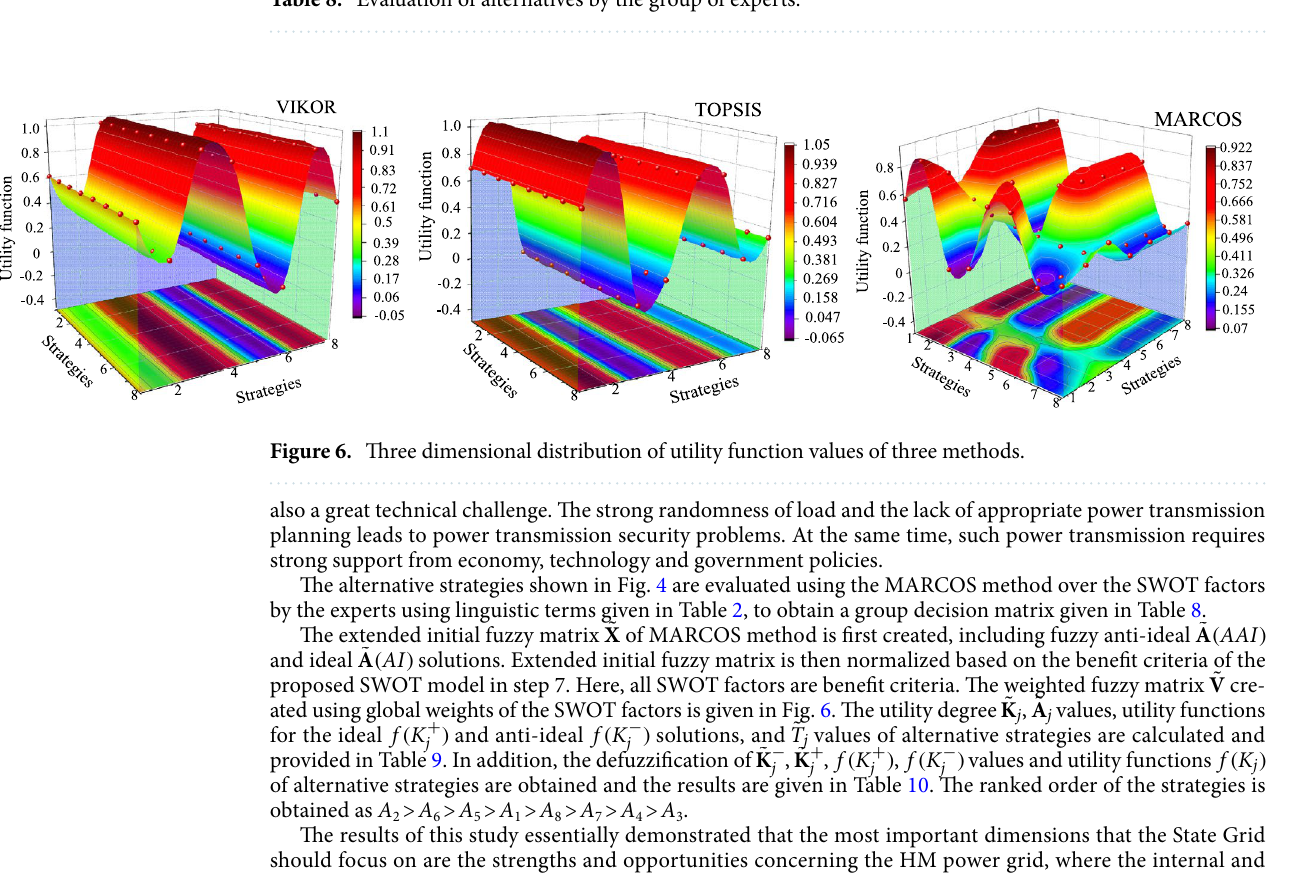
Table 8. Evaluation of alternatives by the group of experts.